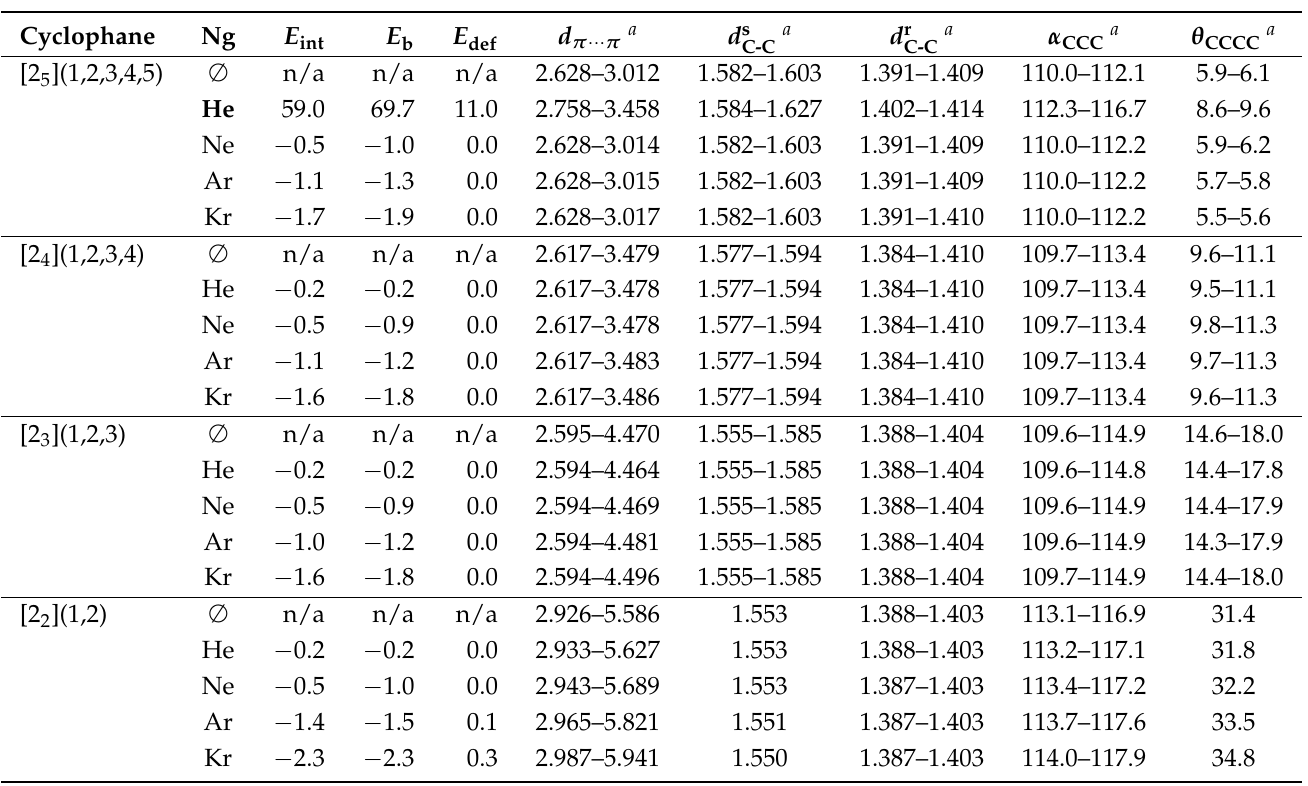
Table 3. Interaction, binding, and deformation energies (in kcal/mol), and selected geometric param- eters (in Å or degrees) for the cyclophane molecule (if ∅ mark is used) and either the Ng@cyclophane (if Ng is marked with boldface) or cyclophane · · · Ng (Ng = He, Ne, Ar, Kr) complexes obtained after geometry optimizations of the initially built Ng@cyclophane